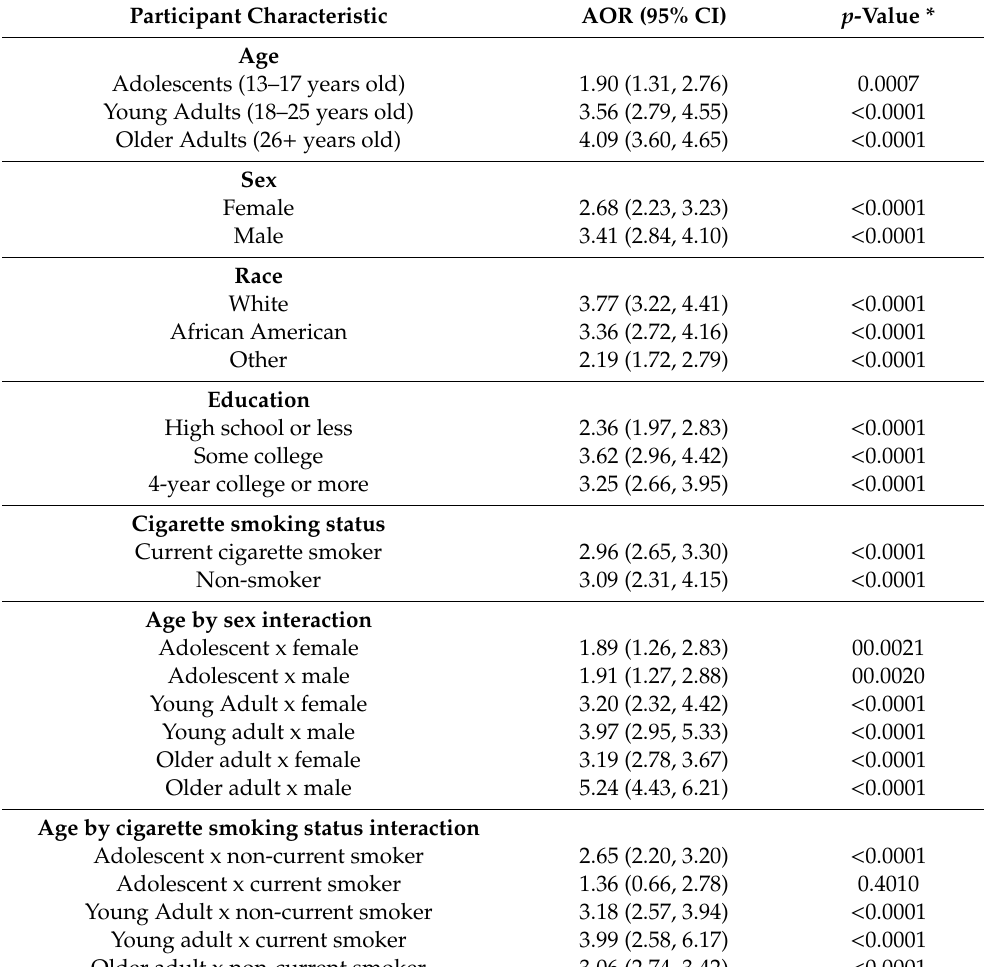
Table 3. Estimated odds of exposure to e-cigarette advertising by participant